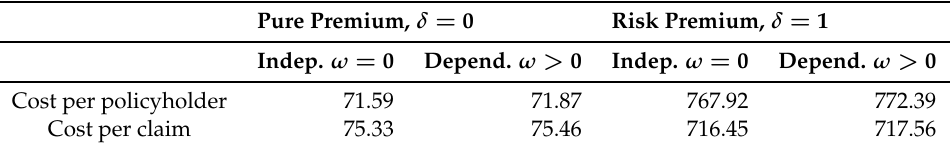
Table 5. Premiums obtained with NB–Lognormal models ( δ = 1 for risk